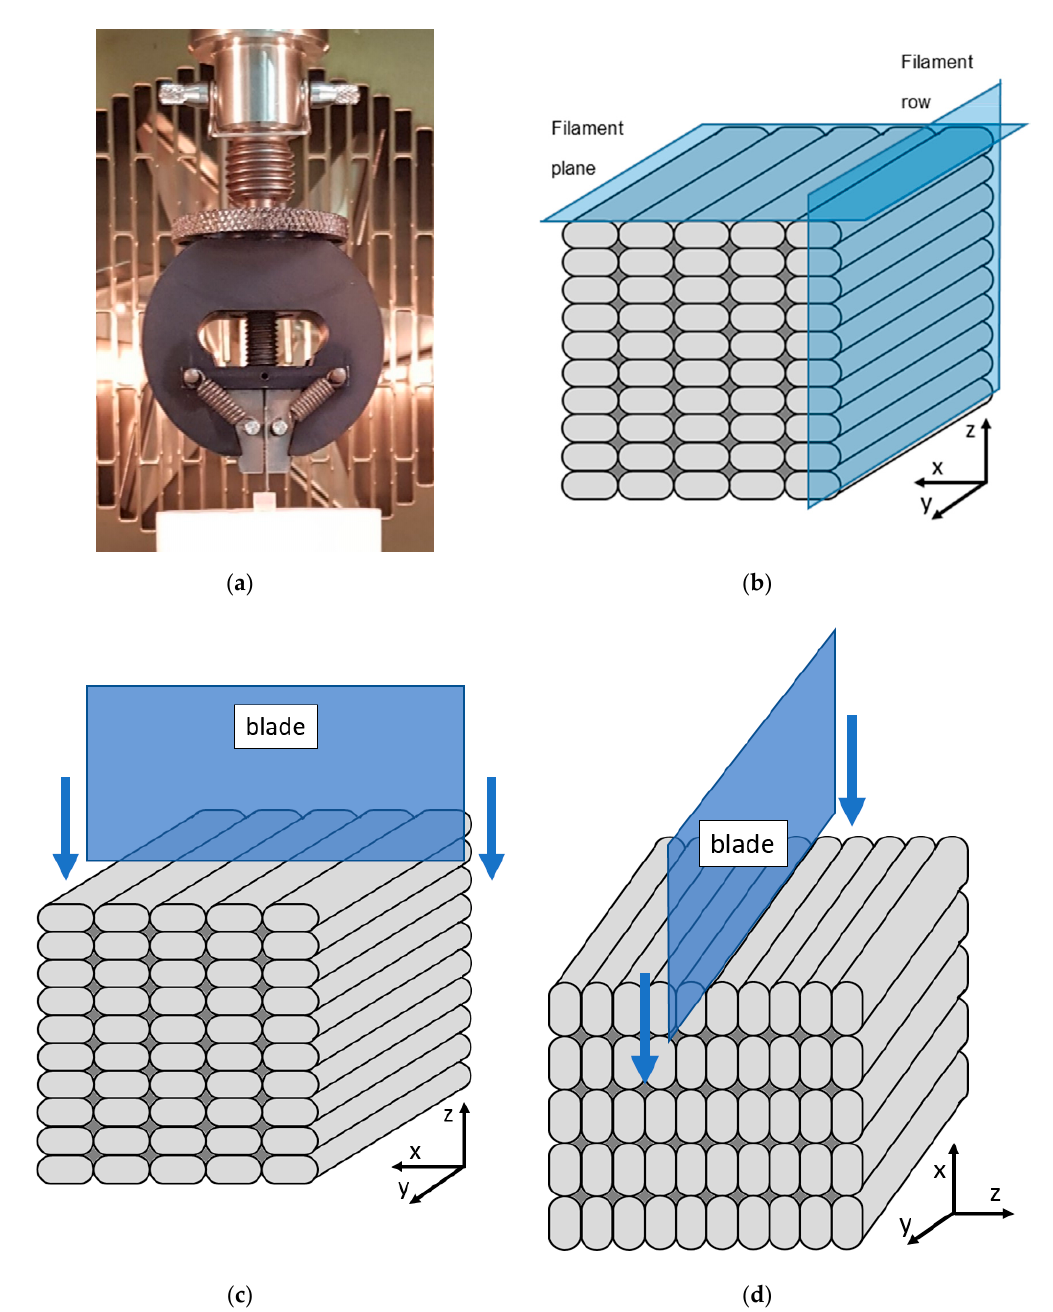
Figure 2. ( a ) displacement clamp with blade and sample (white cube) as used during the mechanical testing; ( b ) schematic of the 3D printed sample; ( c ) schematic of the compression cut test in the xz -direction; ( d ) schematic of the compression cut test in the xy -direction.